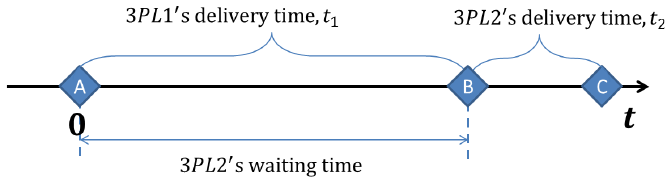
Fig. 2. Serial delivery with waiting cost and without 4PL’s